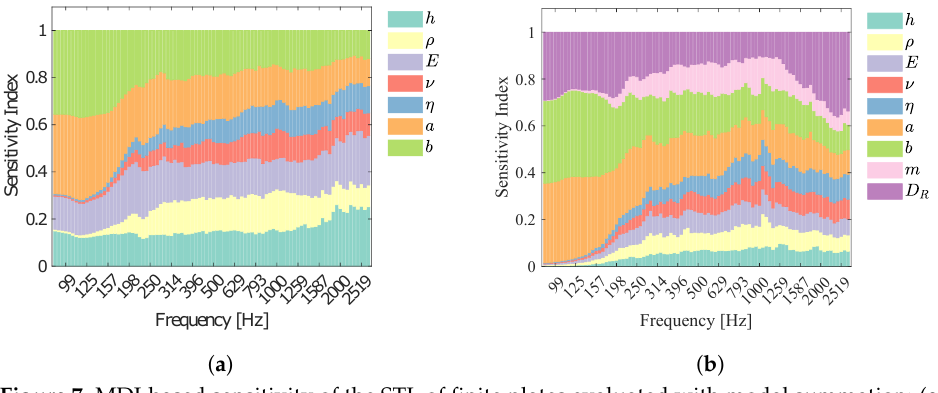
Figure 7. MDI-based sensitivity of the STL of finite plates evaluated with modal summation: ( a ) the inputs of the surrogate only consist of the STL variables ( RMSE = 3.38 ± 0.03 dB); ( b ) physics-guided features m and D R are included as input for the surrogate ( RMSE = 3.24 ± 0.02